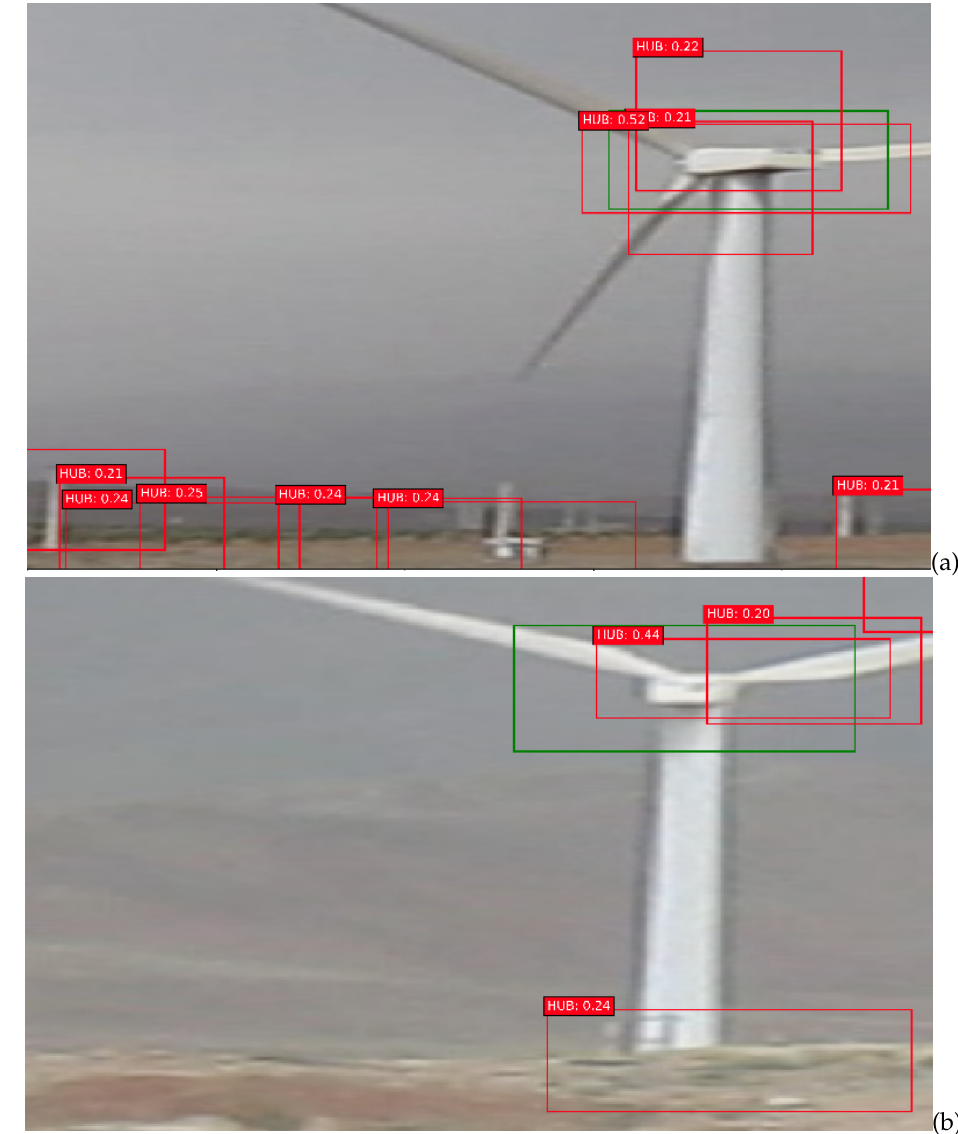
Figure 11. False positive detection without NMS ( epoch = 10, confidence thresh = 0.20, IoU = 0.50) ( a ) The first sample ( b ) The second